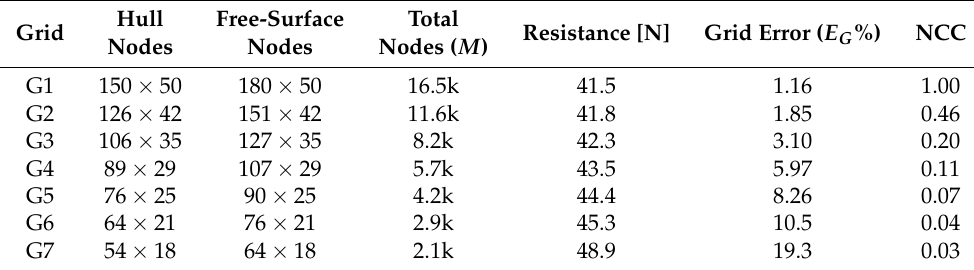
Figure 2. Total resistance convergence ( left ) and grids error with respect to Richardson extrapolation ( right ) for the potential flow solver. Table 2. Fidelity levels details: grid size, resistance, associated error ( E G ), and normalized computa- tional cost